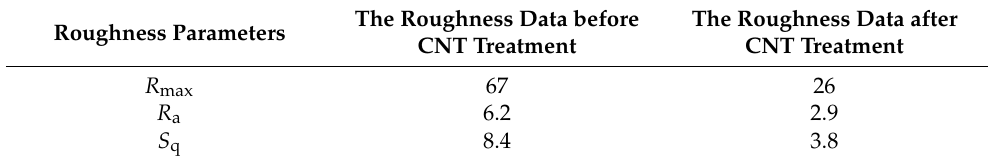
Table 3. Roughness parameters for the MgF 2 structure. The Roughness Data before Roughness Parameters CNT